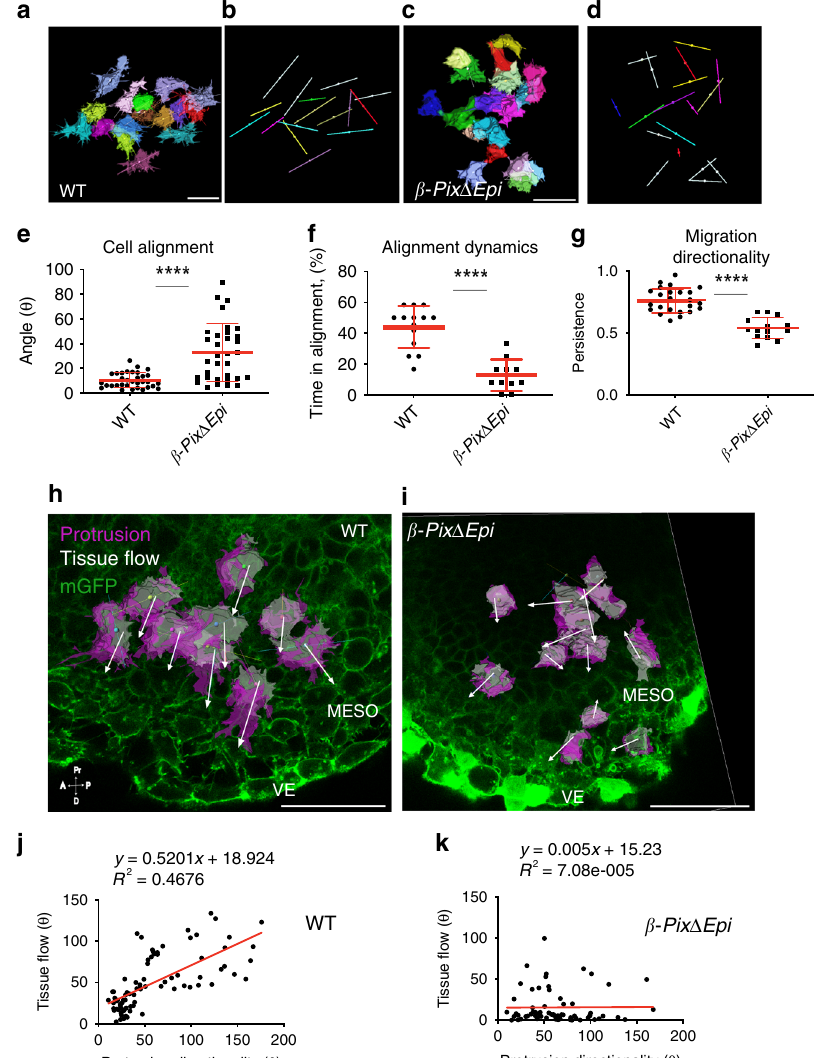
Fig. 6 Directional protrusions drive mesenchymal collective tissue fl ow. a – f β -Pix controls cell alignment. a – d Longest axes with colored cell surfaces ( a , c ) or without them ( b, d ) are generated from membrane-GFP confocal images of mesoderm cells. The longest axis of neighboring mesoderm cells is aligned in wild-type ( a , b ) but not in β -Pix Δ Epi mutants ( c , d ). e Cell alignment is signi fi cantly reduced in β -Pix Δ Epi mutant cells (10 ± 6%; n = 33 wild-type cells; 33 ± 23%; n = 33 mutant cells, 3 embryos); mean ± s.d. **** p < 0.0001 (two-tailed Student ’ s t -test), p = 0.03 (one-way ANOVA). f Percentage of time cells spend in alignment during collective migration. Wild-type cells are aligned 44 ± 14% of the time ( n = 14, 3 embryos); mutant cells are aligned 13 ± 10%; time in alignment is signi fi cantly reduced in mutant embryos ( n = 11 mutant cells, 3 embryos); mean ± s.d. **** p < 0.0001 (two-tailed Student ’ s t -test), p = 0.01 (one-way ANOVA); angles <60° are considered to be aligned. g Directionality of persistent 3D migration is disrupted in β -Pix Δ Epi mutant cells (0.8 ± 0.01; n = 24 wild-type cells, 4 embryos; 0.5 ± 0.09; n = 14 mutant cells, 6 embryos; mean ± s.d. **** p < 0.0001 (by both two-tailed Student ’ s t -test and one-way ANOVA). h , i Time-lapse snapshots at t = 0 and t = 50 min of 3D images from rendered sagittal sections of living mGFP E7.5 embryos. Maps of selected mesoderm cells are shown with magenta protrusions, longest axes (line) and centroids (sphere); projected 3D displacement vectors (white arrows) are shown on the background of the mGFP embryo. Alignment of protrusions and displacement vectors within multiple rows of cells observed in wild-type embryos ( h ) are not detected in β -Pix Δ Epi mutant embryos ( i ). j , k Correlation plots graphing protrusion directionality ( X ) and tissue fl ow angles ( Y ) for 80 wild type and 66 mutant X – Y pairs show signi fi cant correlation coef fi cient r = 0.7 for wild-type cells ( j ) and loss of correlation ( r = 0.05) in β -Pix Δ Epi mutant cells ( k ). The statistical difference between distributions of i , j assessed by Chi-squared test of two degrees of freedom was p < 10 − 8 . Scale bar, 50 µ m ( a – d , h , i Formation of these fi lopodia-like structures depends on the GEF β -Pix. In the absence of β -Pix in live embryos, only short stubby cellular protrusions form, and cells do not touch their neighbors with fi lopodia or move in coordination. β -Pix is an activator of RAC1 and CDC42, and acts by regulating the dynamics of lamel- lipodia and focal adhesions that allow forward movement of cells 24 . We previously showed that mesoderm migration fails in mouse fully active until ~E7.5. In contrast, our manuscript describes the embryos that lack Rac1 in epiblast-derived cells 11 . Rac1 mutant result of complete elimination of β -Pix in the epiblast and its